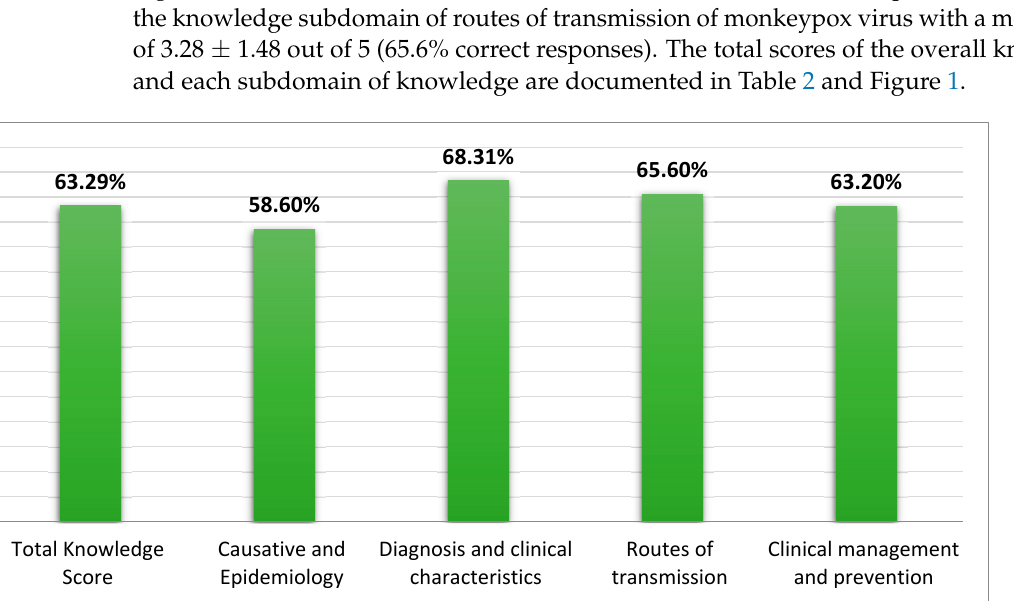
Figure 1. Overall knowledge scores and subdomains. NB: %s refer to mean scores.